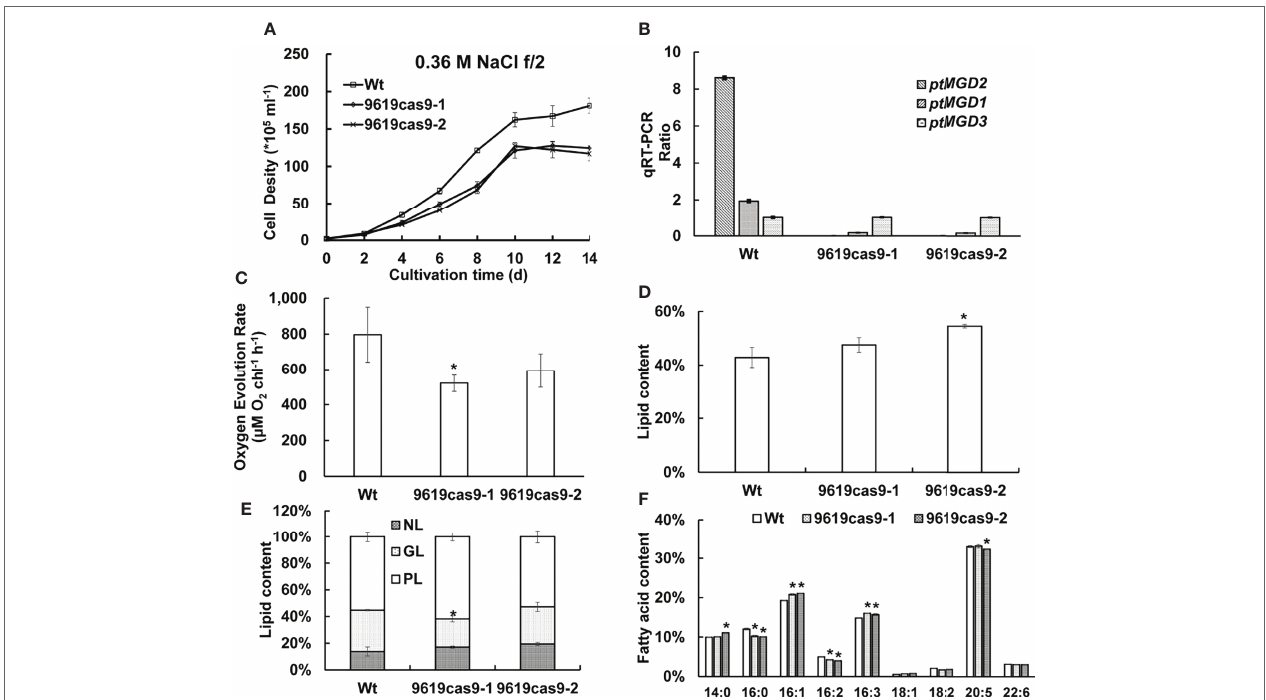
FIGURE 4 | Effect of the ptMGD2 gene inactivation on cell phenotype analyses. The Wt and the knockout lines were compared regarding their growth rates (A) and qRT-PCR ratio of the mRNA abundance of three MGDs in Wt and the ptMGD2 knockout mutants under normal conditions (B) . Analysis of oxygen evolution rate (C) , total lipid content (D) , lipid class ratio (E) , fatty acid content (F) from Wt and the ptMGD2 mutants were performed. NL, neutral lipid; GL, glycolipid; PL, phospholipid. All values represent means ± standard deviations of three biological repeats. Asterisk represents statistically significant differences between wild-type and mutants based on Student’s t test (* p <